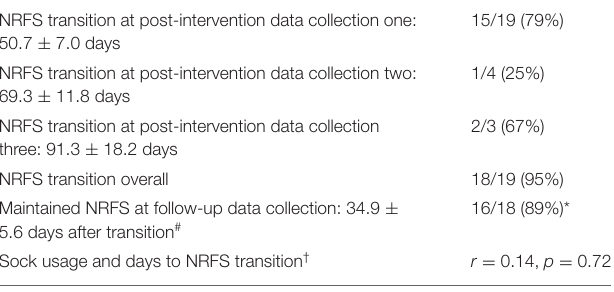
TABLE 2 | Rearfoot strike to non-rearfoot strike transition description ( n =